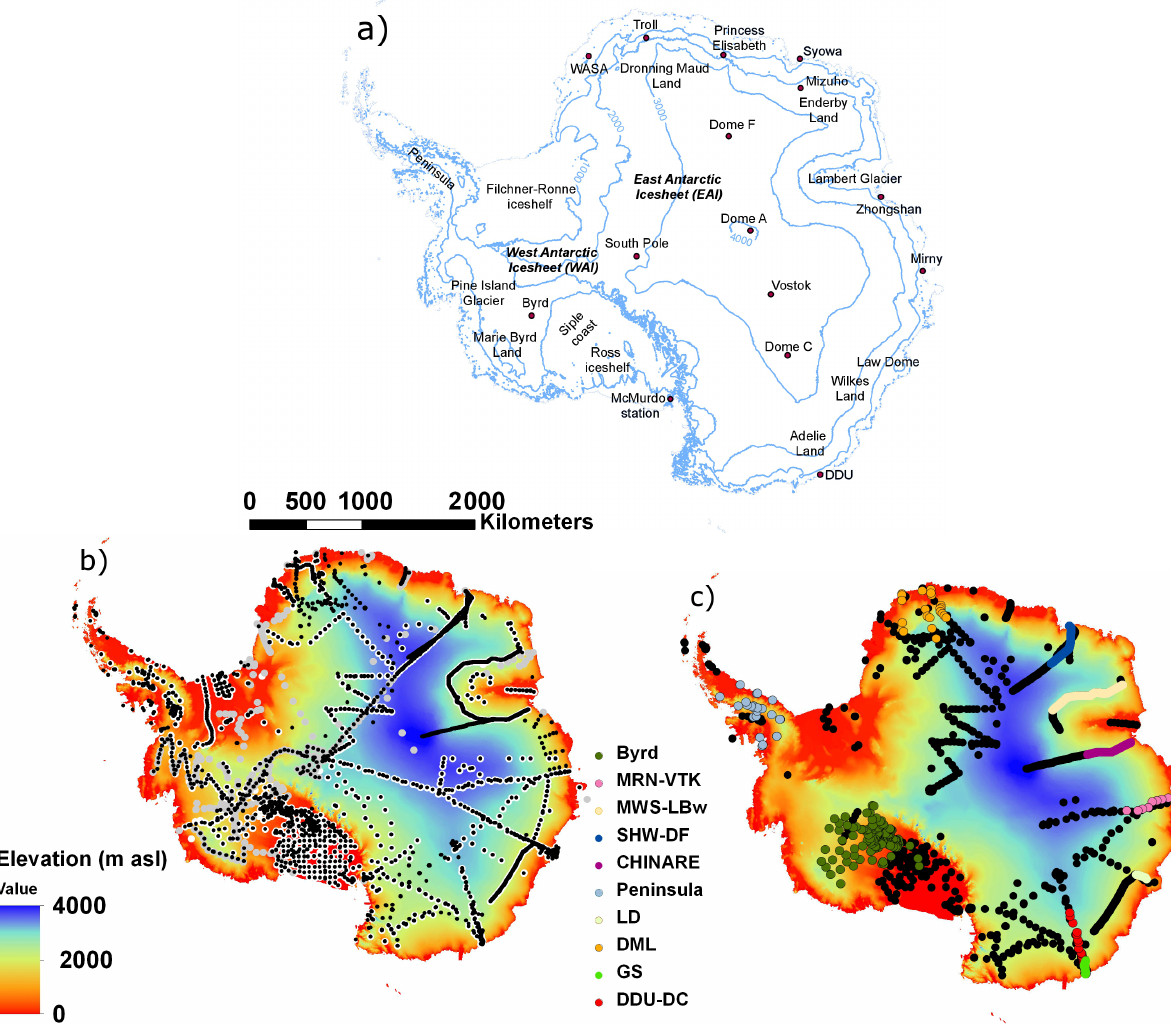
Fig. 1. (a) Orientation map of Antarctica showing the main regions cited in the text. Blue lines are 1000m elevation contours computed from Bamber et al. (2009). (b) Location of available SMB data in Antarctica. White circles are data from V99’s database, black dots represent data from the updated database before quality control, gray circles represent data from Bull (1971) which were directly excluded from the Vaughan et al. (1999) database due to their low reliability (digitalized from maps). Background map is elevation according to (Bamber, 2009). (c) Lo- cation of reliable field data (black dots) and selected datasets for model validation. Background map is elevation according to (Bamber, 2009). Abbreviations are CAS: Casey (Vincennes Bay, Australia), DC: Dˆome C (Antarctic Plateau, France/Italy, DDU: Dumont d’Urville (Adelie Land, France), DF: Dome Fuji (Dronning Maud Land, Japan), LD: Law Dome (Wilkes Land, Australia), GS: GLACIOCLIM-SAMBA net- work, MRN: Mirny (Davis Sea, Russia), MWS: Mawson (Mac Robertson Land, Australia), NMY: Neumayer (Atka-Bay, Germany), SHW: Syowa (East Ongul Island, Japan), SP: Amundsen–Scott South Pole (South Pole, USA), TRL for Troll (Dronning Maud Land, Norway), VTK: Vostok (Antarctic Plateau, Russia), ZGS: Zhongshan (Prydz Bay,